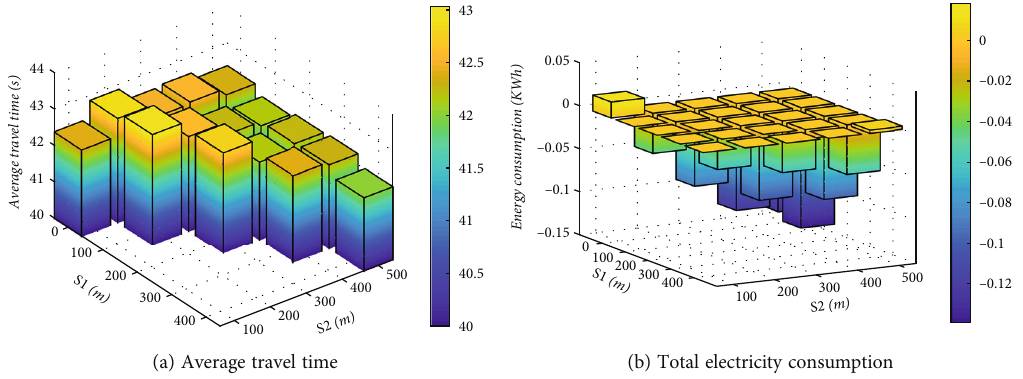
Figure 8: Tra ffi c bene fi ts of di ff erent charging locations in mixed tra ffi